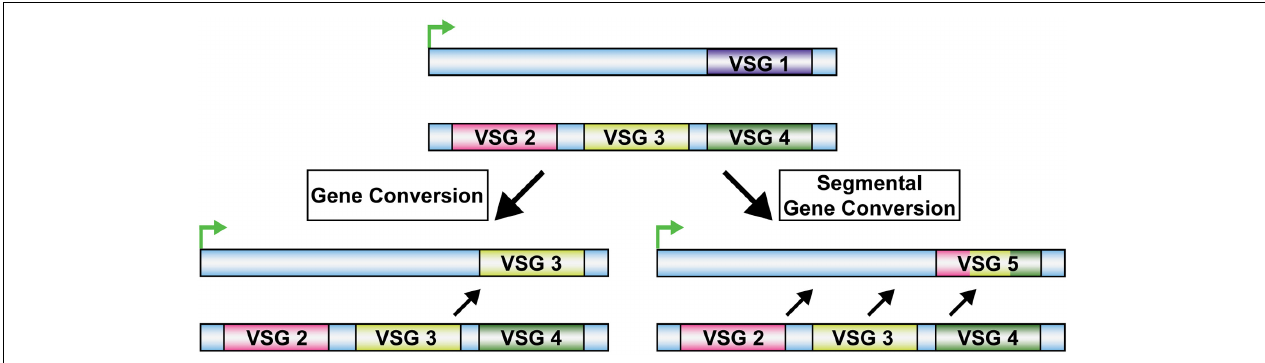
FIGURE 2 | Trypanosoma brucei Homologous Recombination VSG Switching. VSG Switching by homologous recombination in T. brucei occurs through gene conversion. This can occur by exchanging a VSG gene into a transcriptionally active site or through multiple VSG gene segment conversions into the transcriptionally active